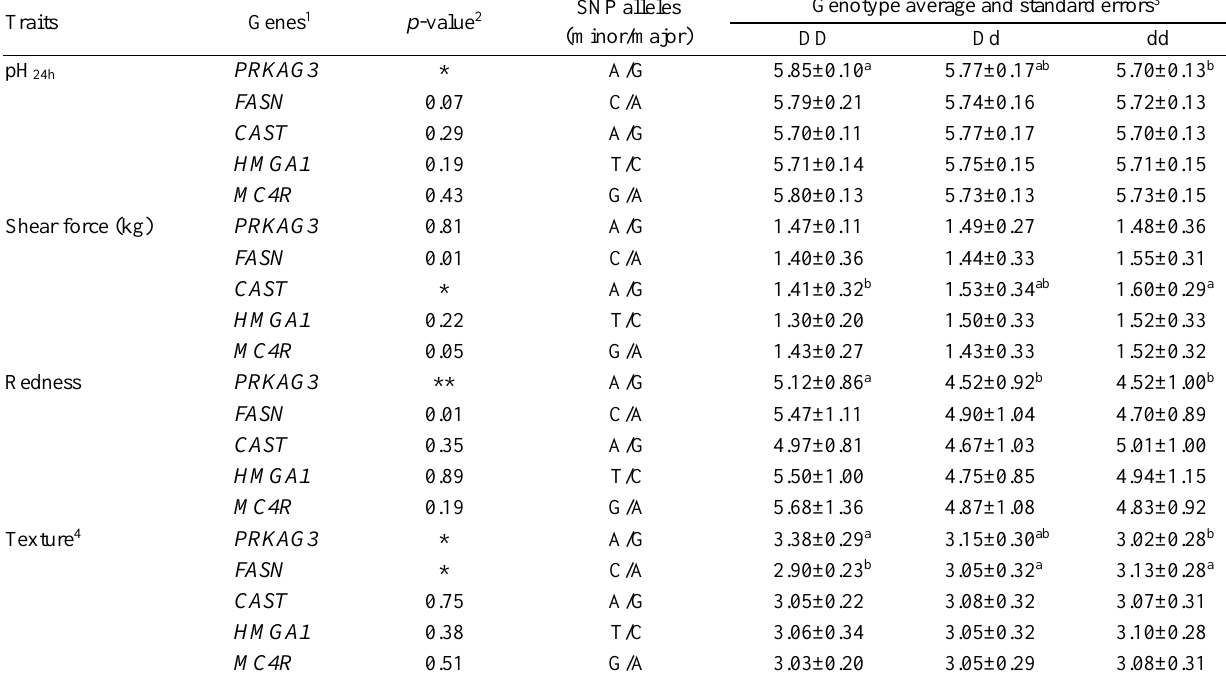
Table 5. Association of SNP genotypes and their harboring genes with meat quality traits of LD muscle in Duroc breeding stock